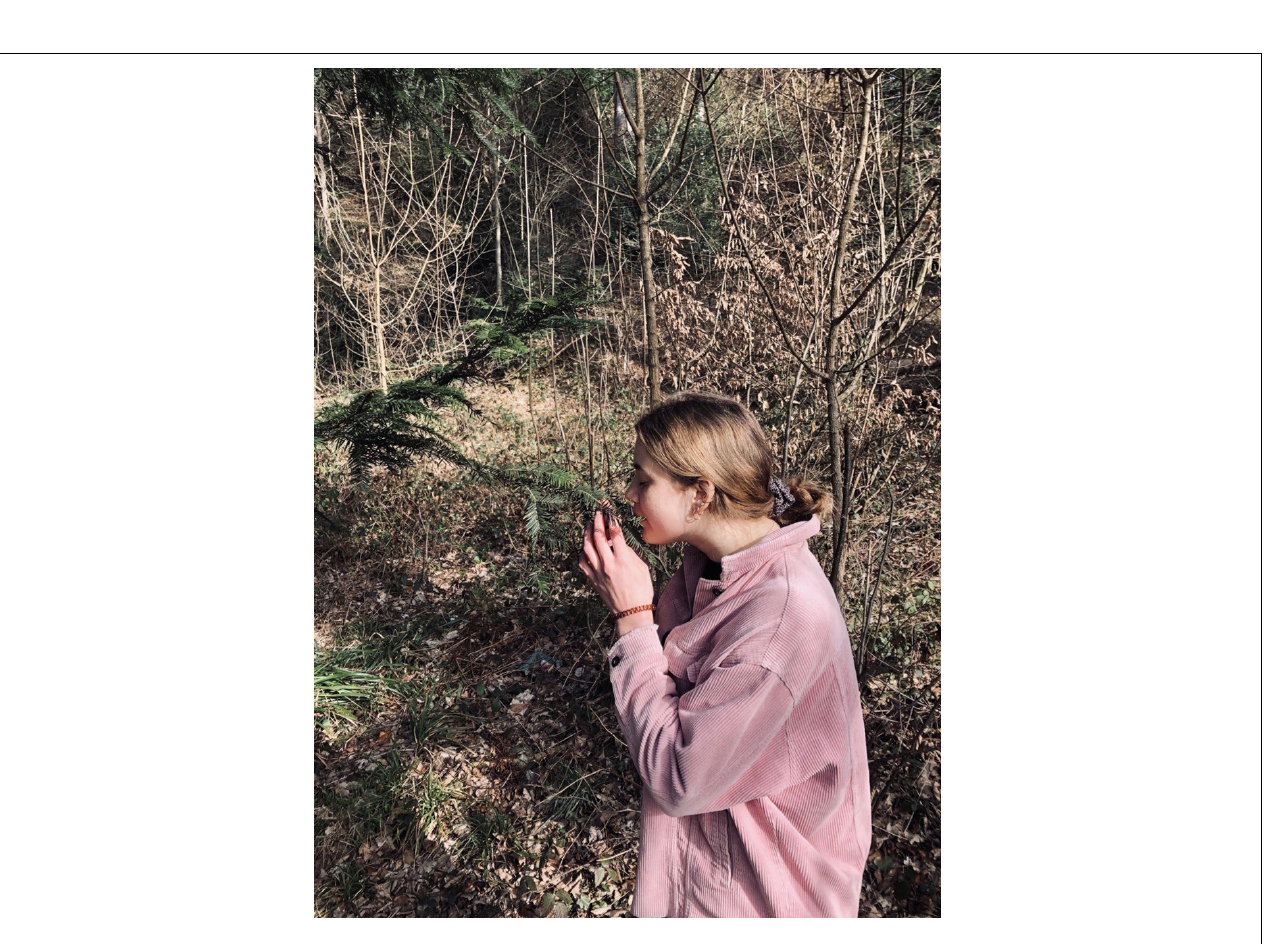
Frontiers in Forests and Global Change |